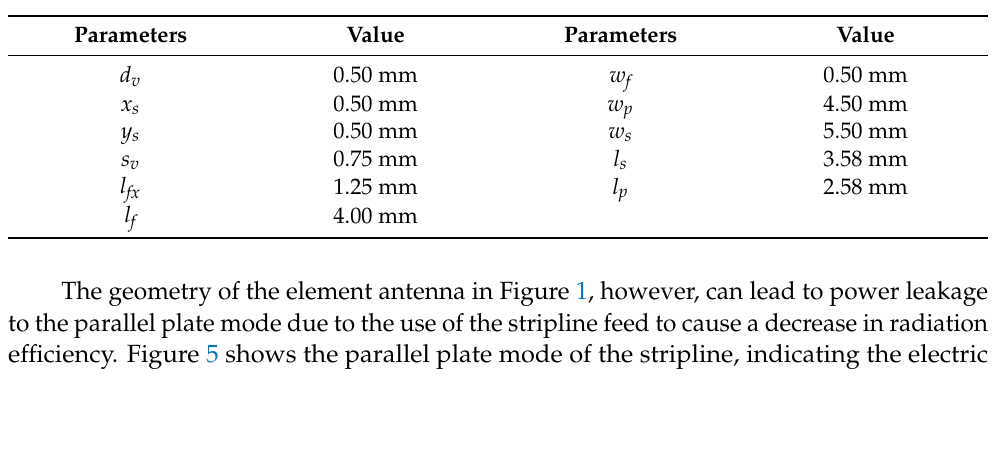
Figure 4. Simulated results of the proposed element antenna. ( a ) |S11|. ( b ) Radiation patterns at 26.2 GHz. Table 1. Dimensions of the Element Patch